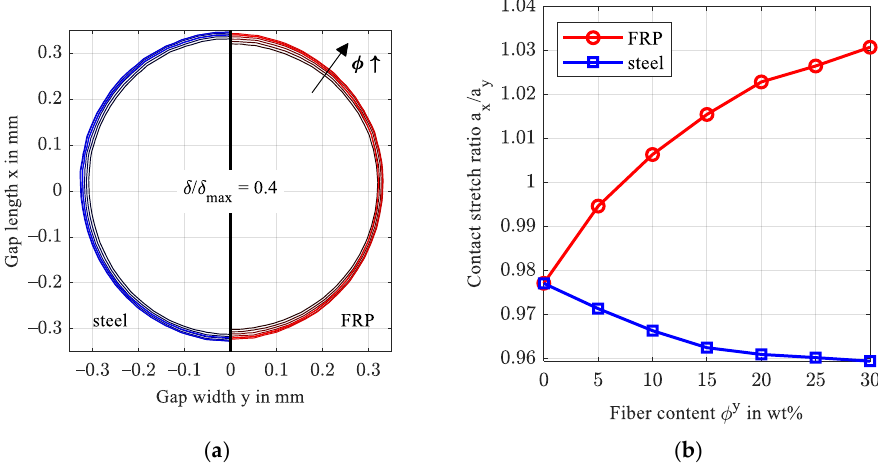
Figure 8. Normalized contact deformation of the steel and FRP surface for increasing fiber content in the y-direction ( a ) and contact stretch ratio ( b